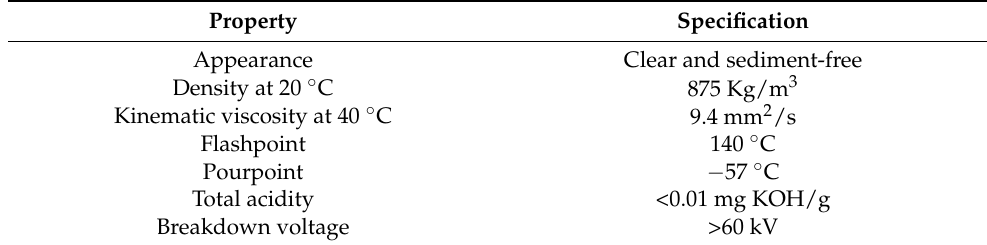
Table 2. Specifications of fresh oil used.